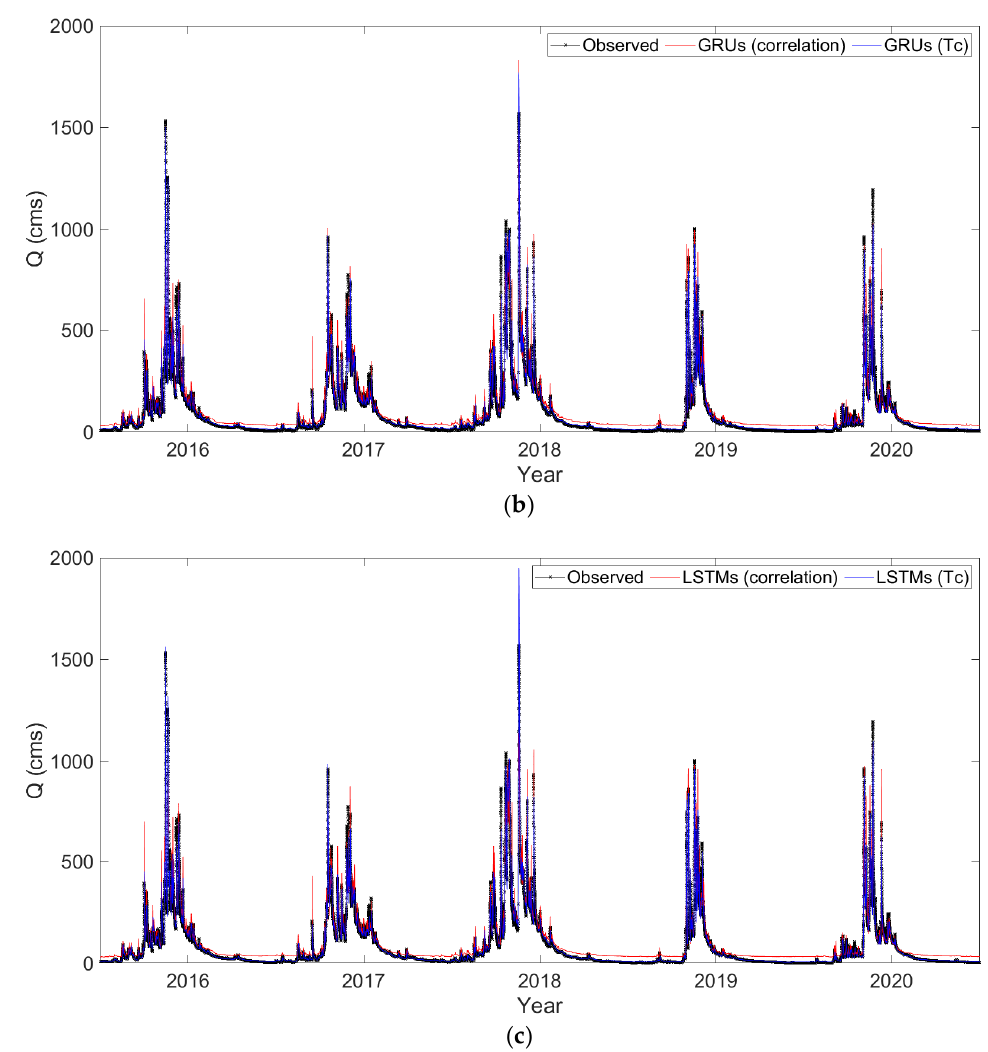
Figure 5. The comparison of observed discharge and 12-h predicted discharge using deep learning model for the Upper Nan River basin ( a ) RNNs ( b ) GRUs and ( c ) LSTMs.